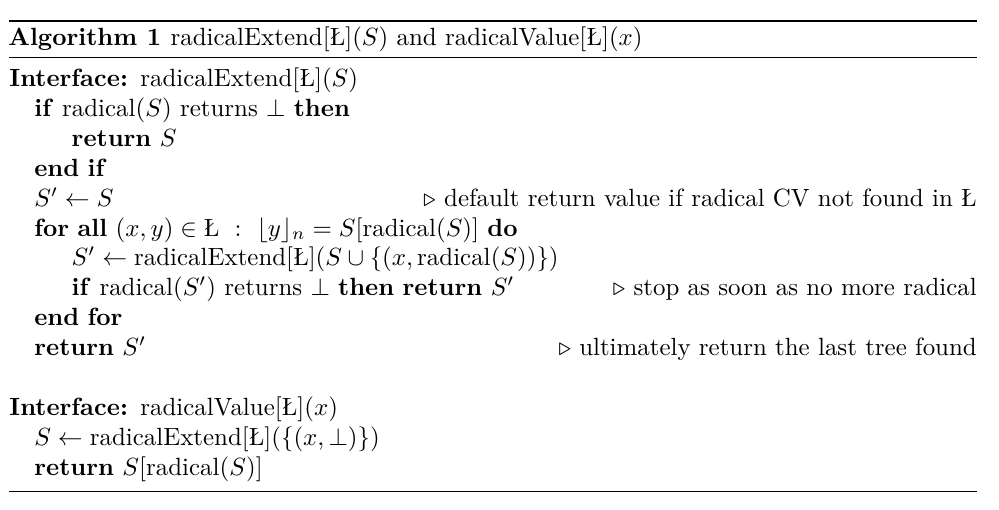
Algorithm 1 radicalExtend[Ł]( S ) and radicalValue[Ł]( x